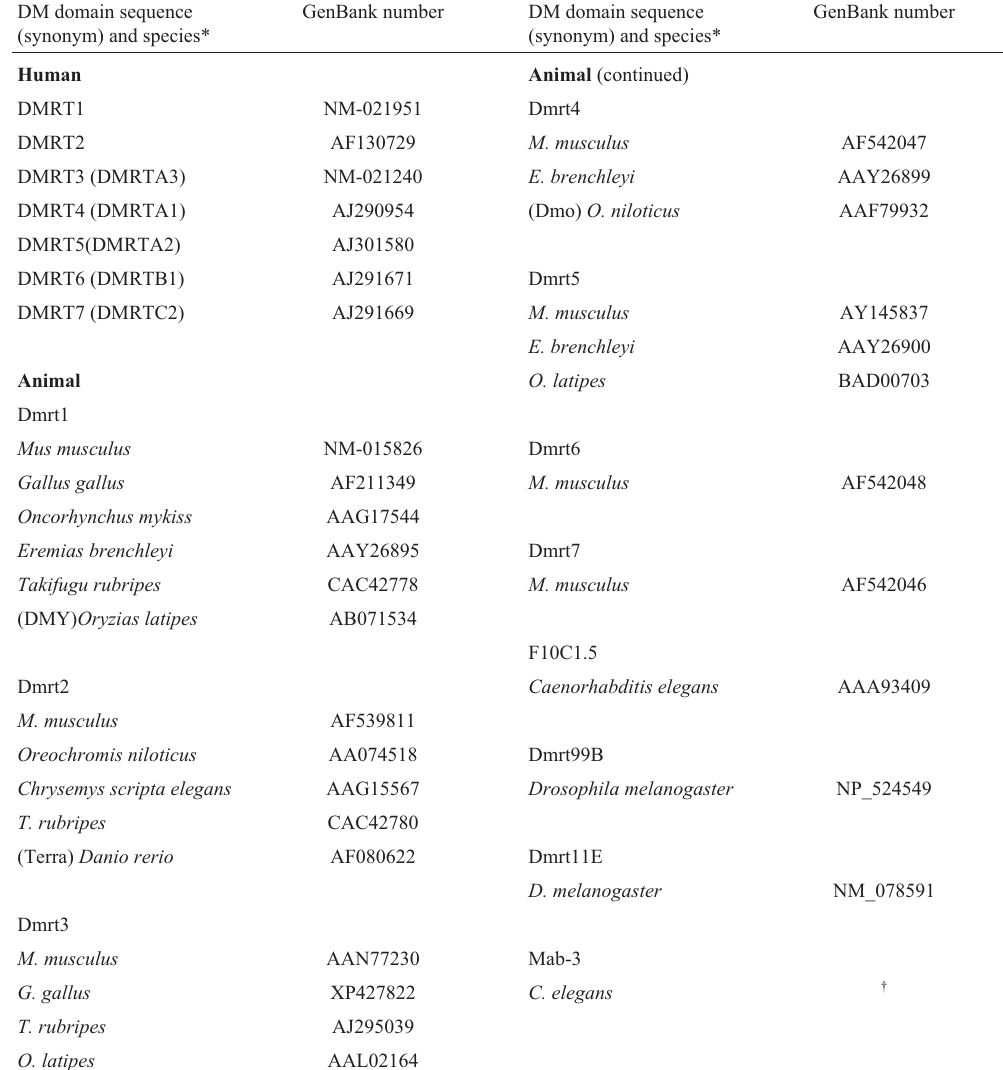
Table 1 - Doublesex/male abnormal 3 (dsx/mab-3 or DM) related transcription factor (DMRT) domain sequences included in this analysis. DM domain sequence (synonym) and